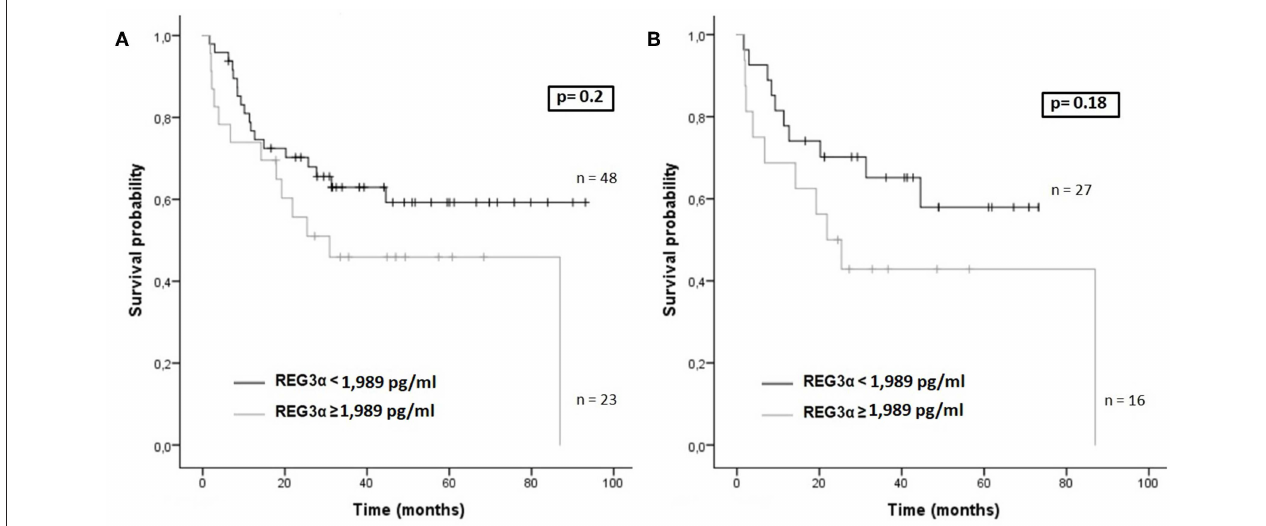
FIGURE 6 | (A) Overall survival according to REG3 α levels at day + 30 (cut-off 1,989 pg/ml) in the whole cohort ( n = 71). (B) Overall survival according to REG3 α levels at day + 30 (cut-off 1,989 pg/ml) in RIC patients ( n =